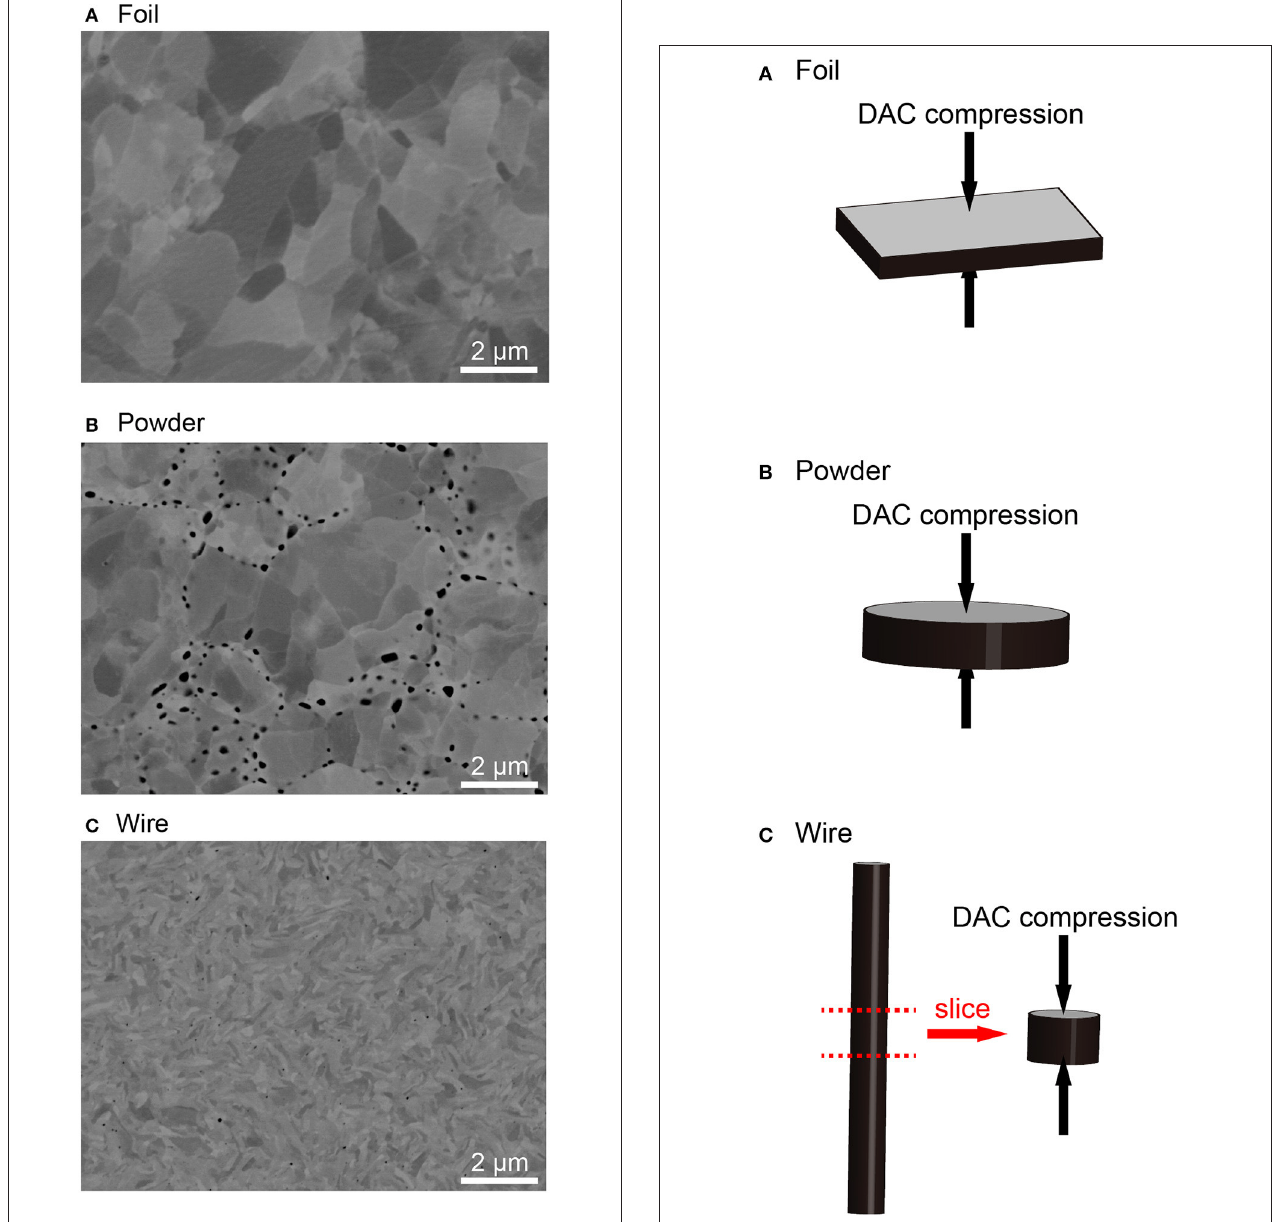
FIGURE 2 | Schematics of iron starting materials. Black arrows indicate the compressional direction of a DAC. (A) Iron foil with initial thickness of 10 µ m. (B) Iron powder that was sintered in a D-DIA apparatus at 2 GPa and 600 ◦ C for 1h, then deformed uniaxially with approximate strain rate of 2 × 10 − 5 s − 1 at room temperature. (C) Iron wire (100 µ m in diameter) was sliced to about 10 µ m